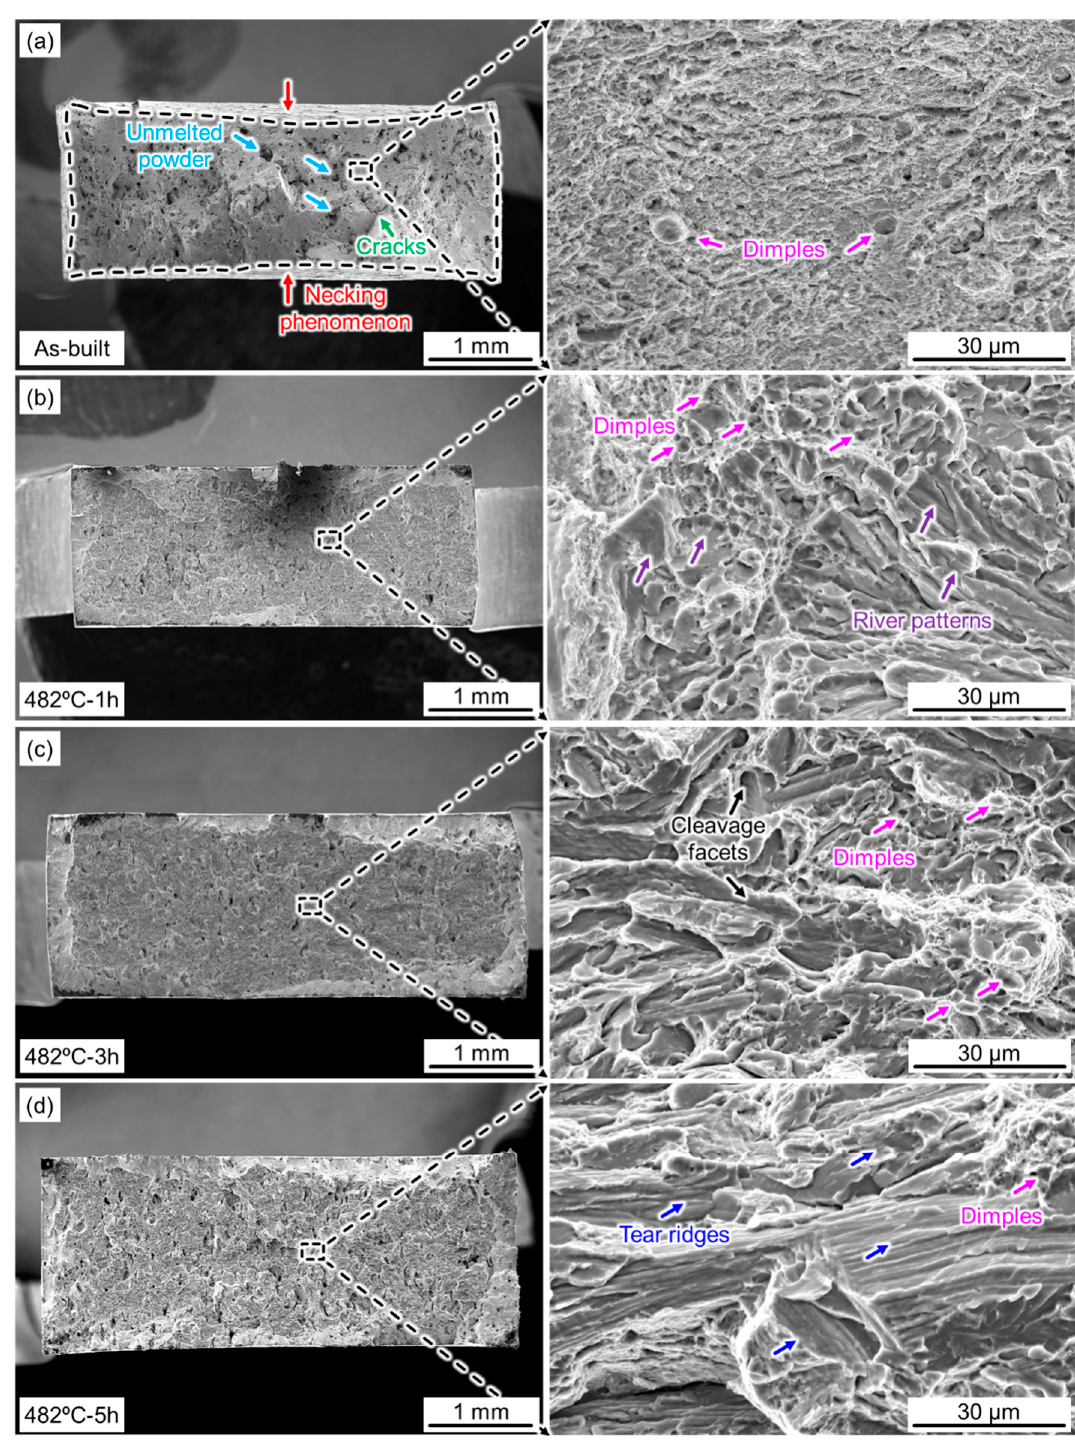
Figure 10. Fractographic features of the SLM 17-4 PH steel samples under di ff erent conditions: ( a ) as-built; ( b ) aged at 482 °C for 1 h; ( c ) aged at 482 °C for 3 h; ( d ) aged at 482 °C for 3 h.